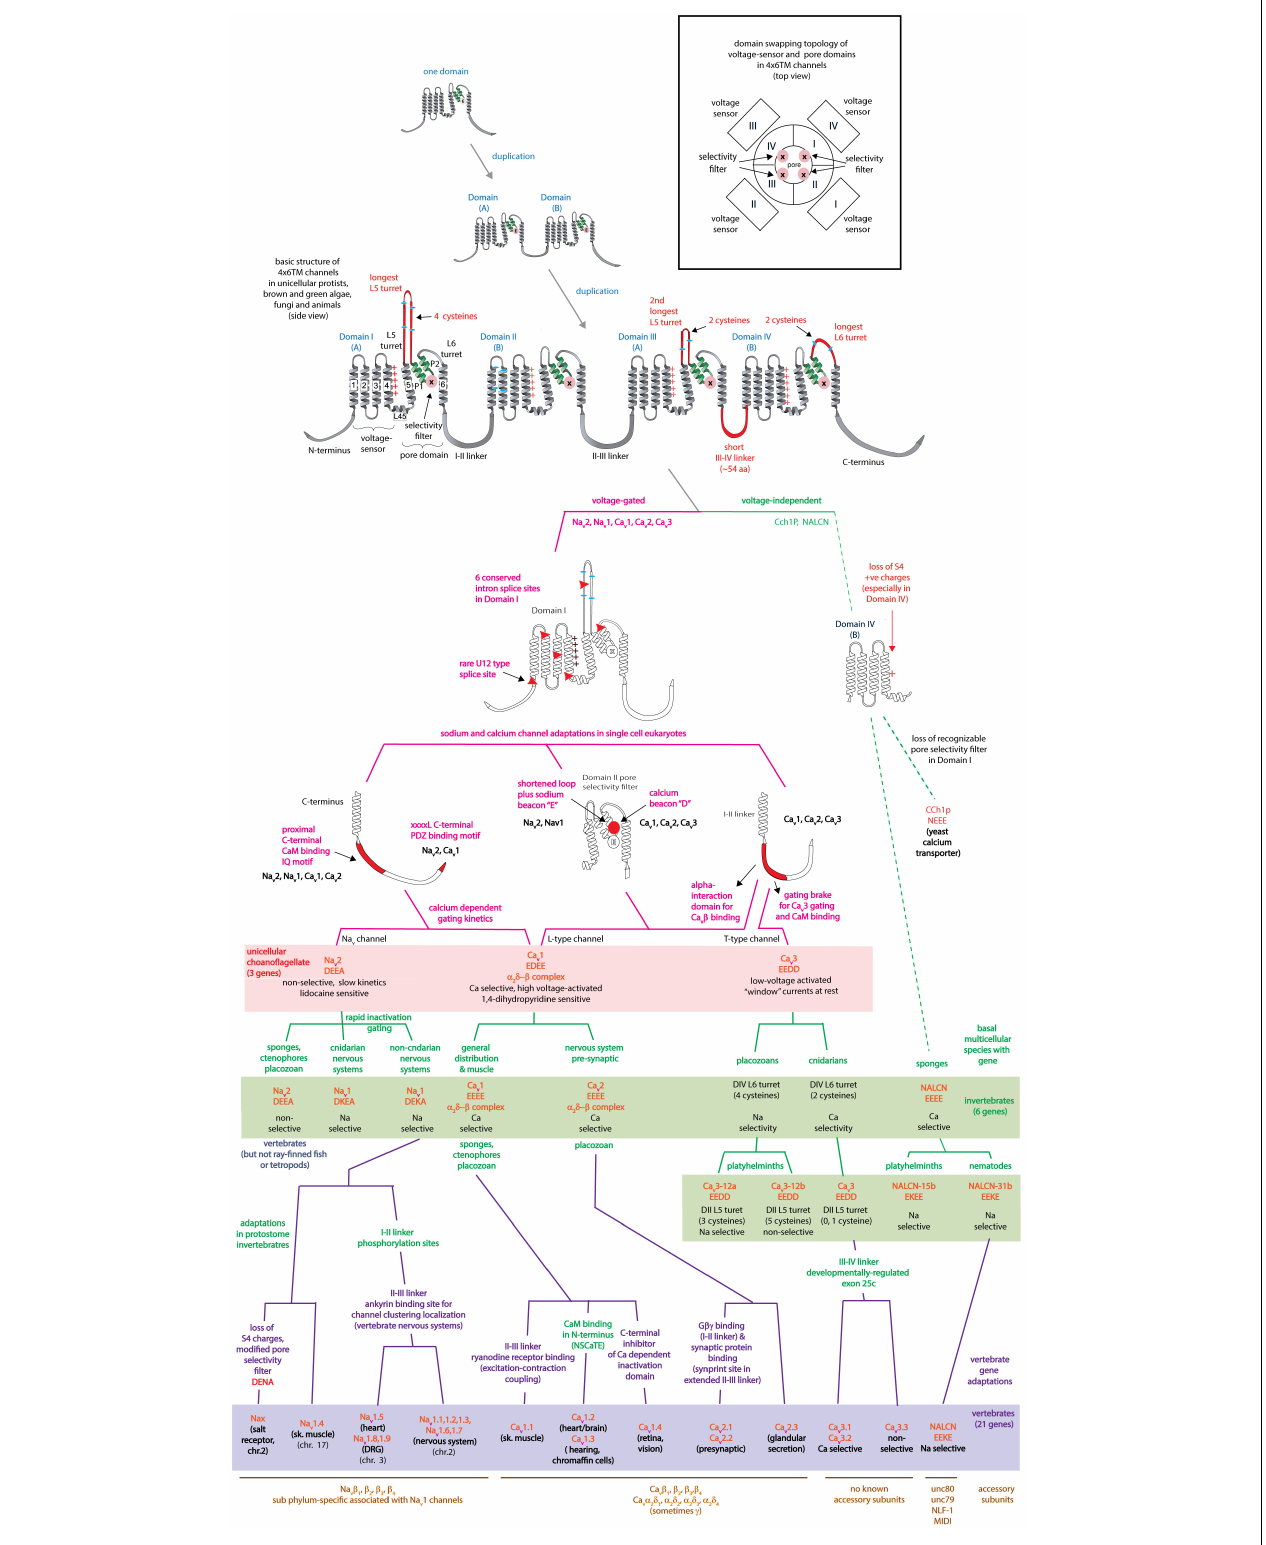
FIGURE 13 | Flow chart illustrating progression of features evolving within 4 × 6 TM cation channels, including the three primary voltage-gated channels contained in single cell choanoflagellates (Na v 2, Ca v 1, and Ca v 3) (pink color, 3 genes) and their diversification and specialization within protostome invertebrates (green color, 6 genes) and vertebrates (purple color, 21